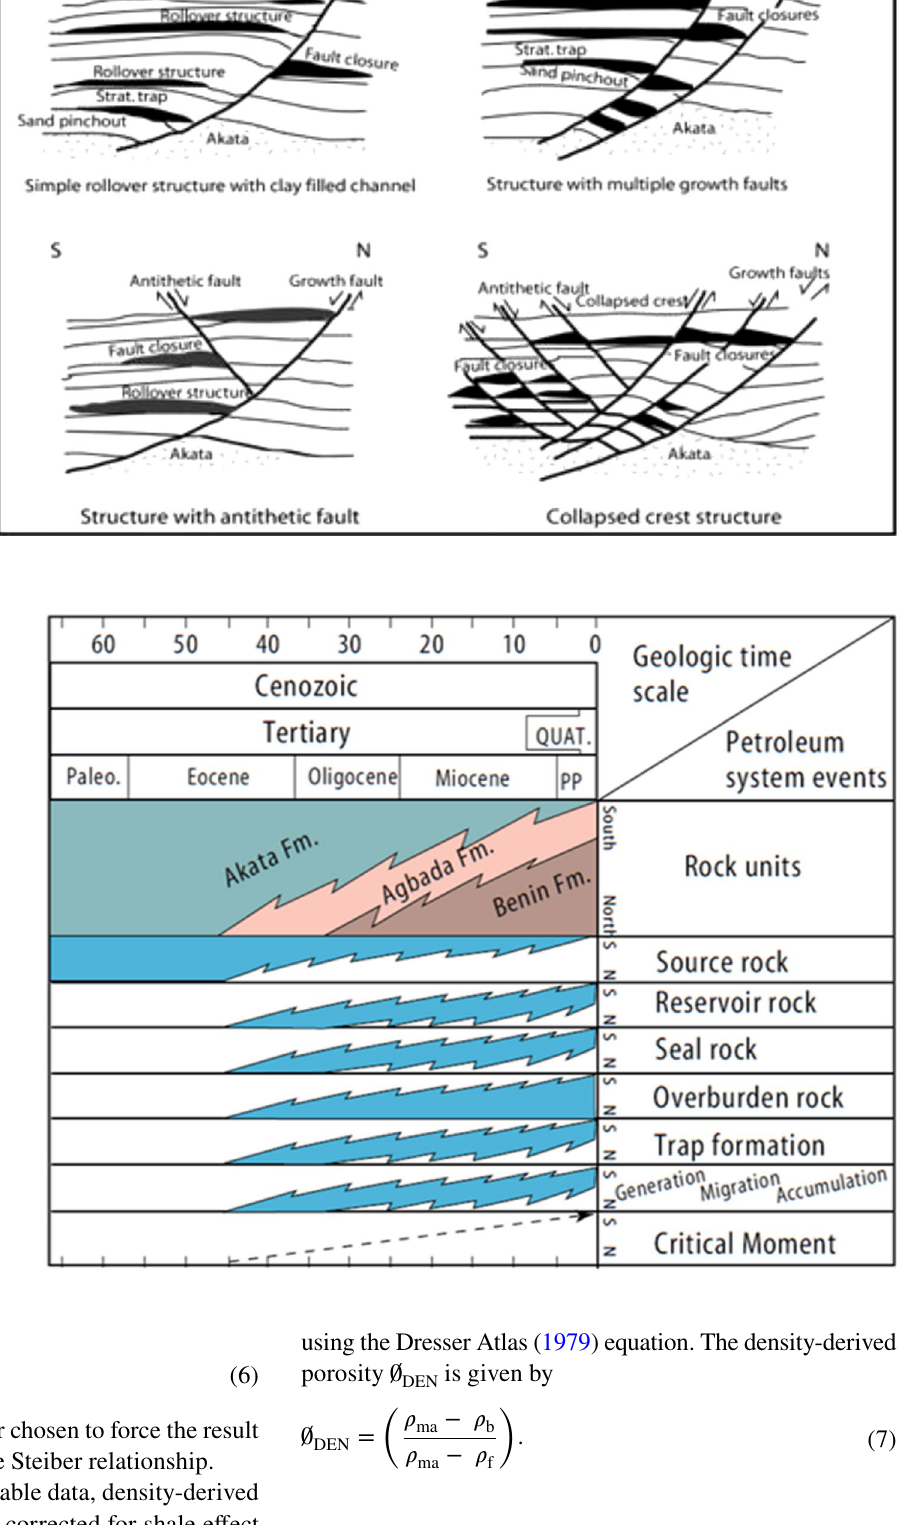
Fig. 5 Principal types of oilfield